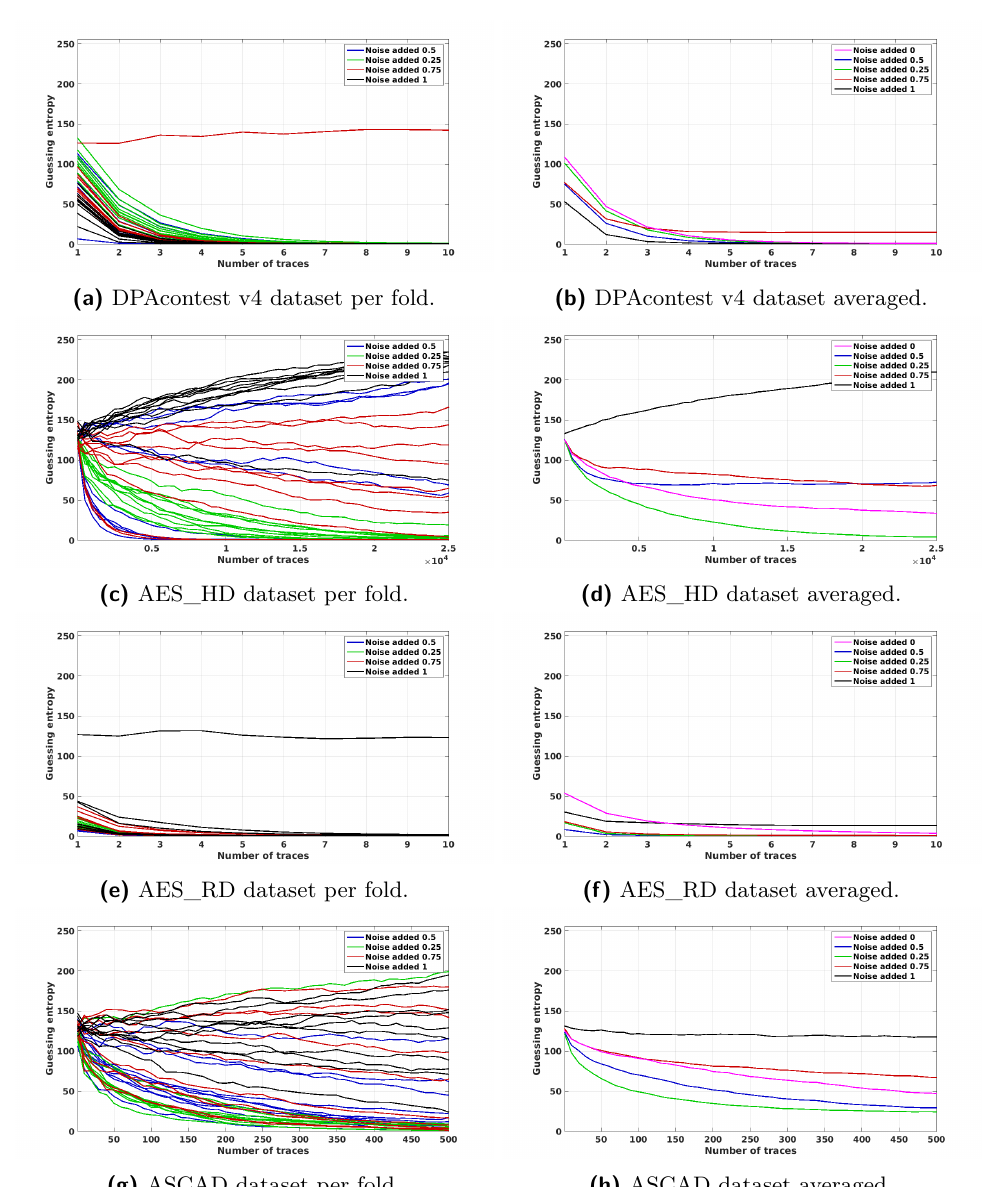
Figure 7: Guessing entropy results for the the RD network with different levels of noise, all